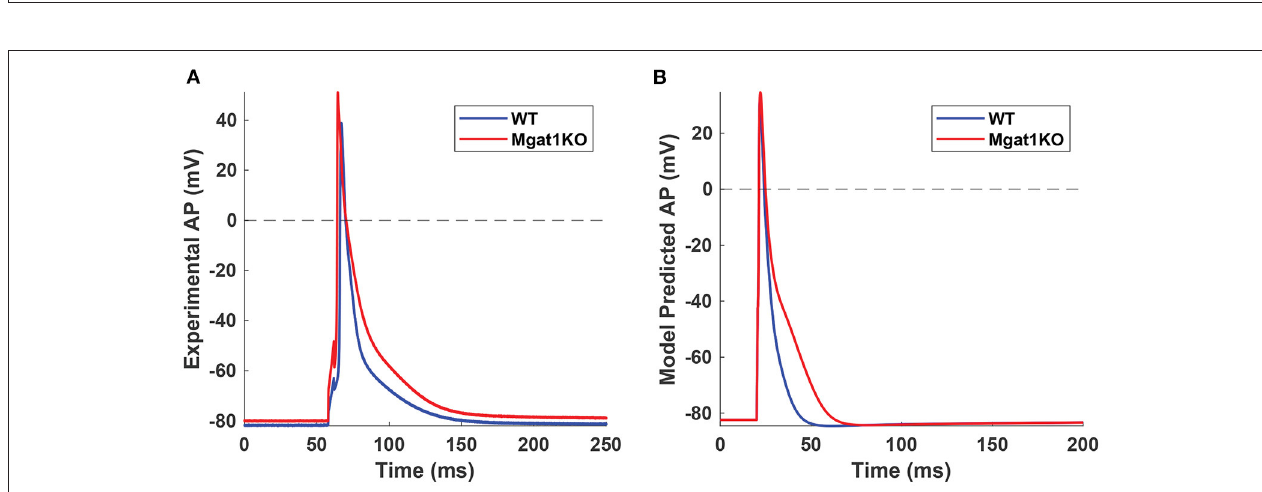
FIGURE 8 | Predicted steady-state inactivation to voltage relationship under the WT and Mgat1KO conditions. (A) I Kto . (B) I Kslow . Voltage steps range from -60 to 50 mV by 10-mV increments.